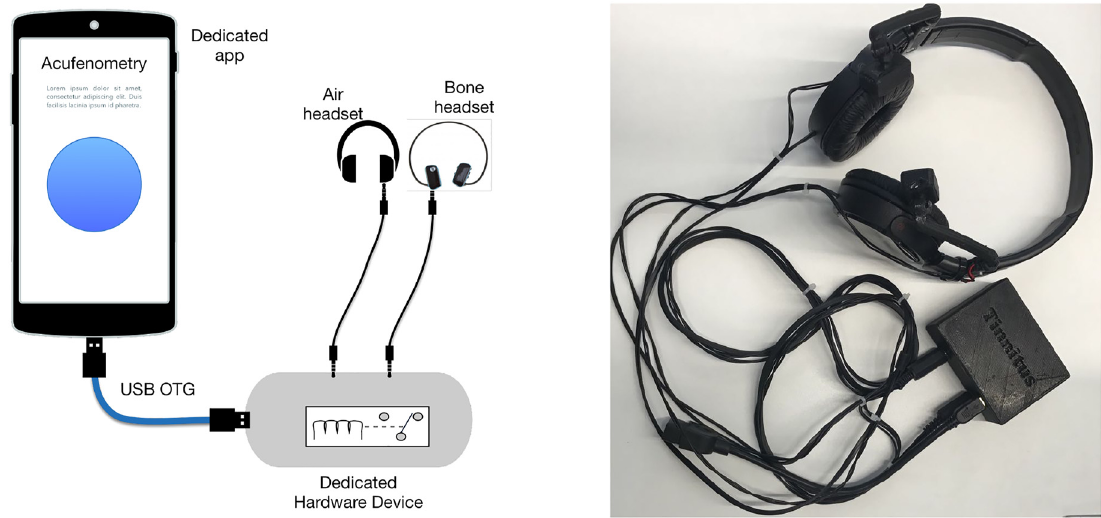
Figure 1: The dedicated device acts as a external peripheral controlled by the app.